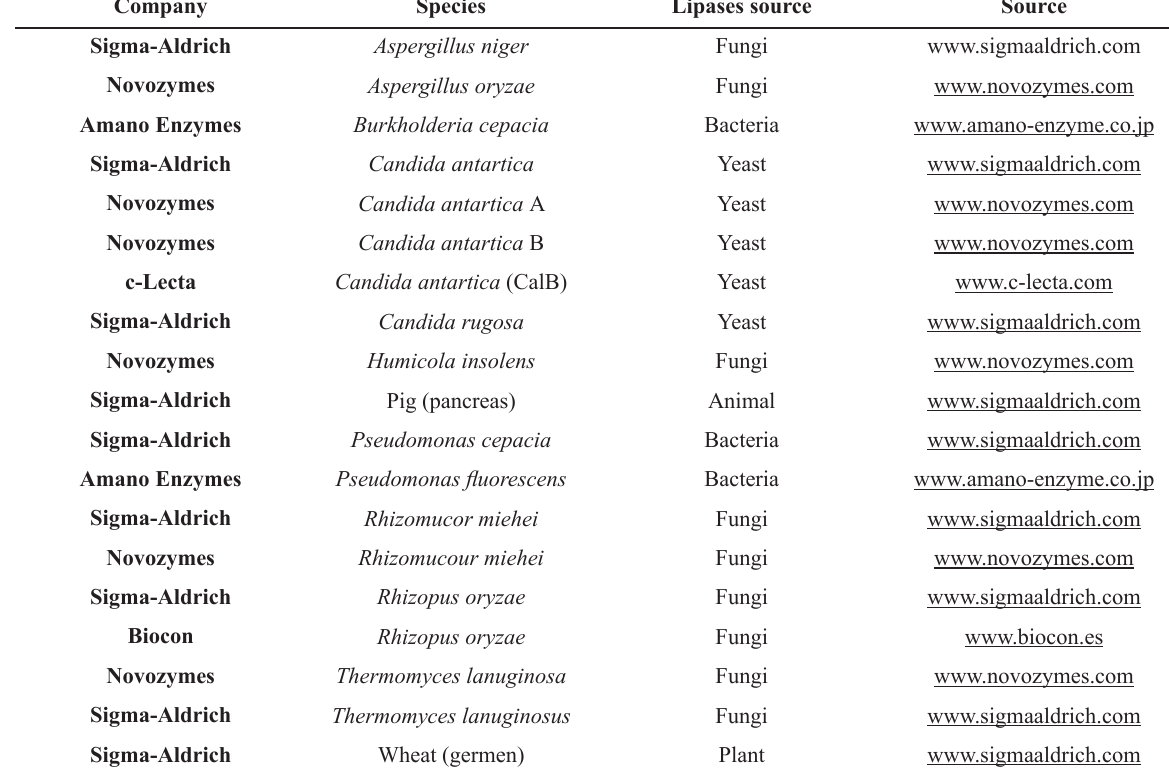
Species used as commercial lipases